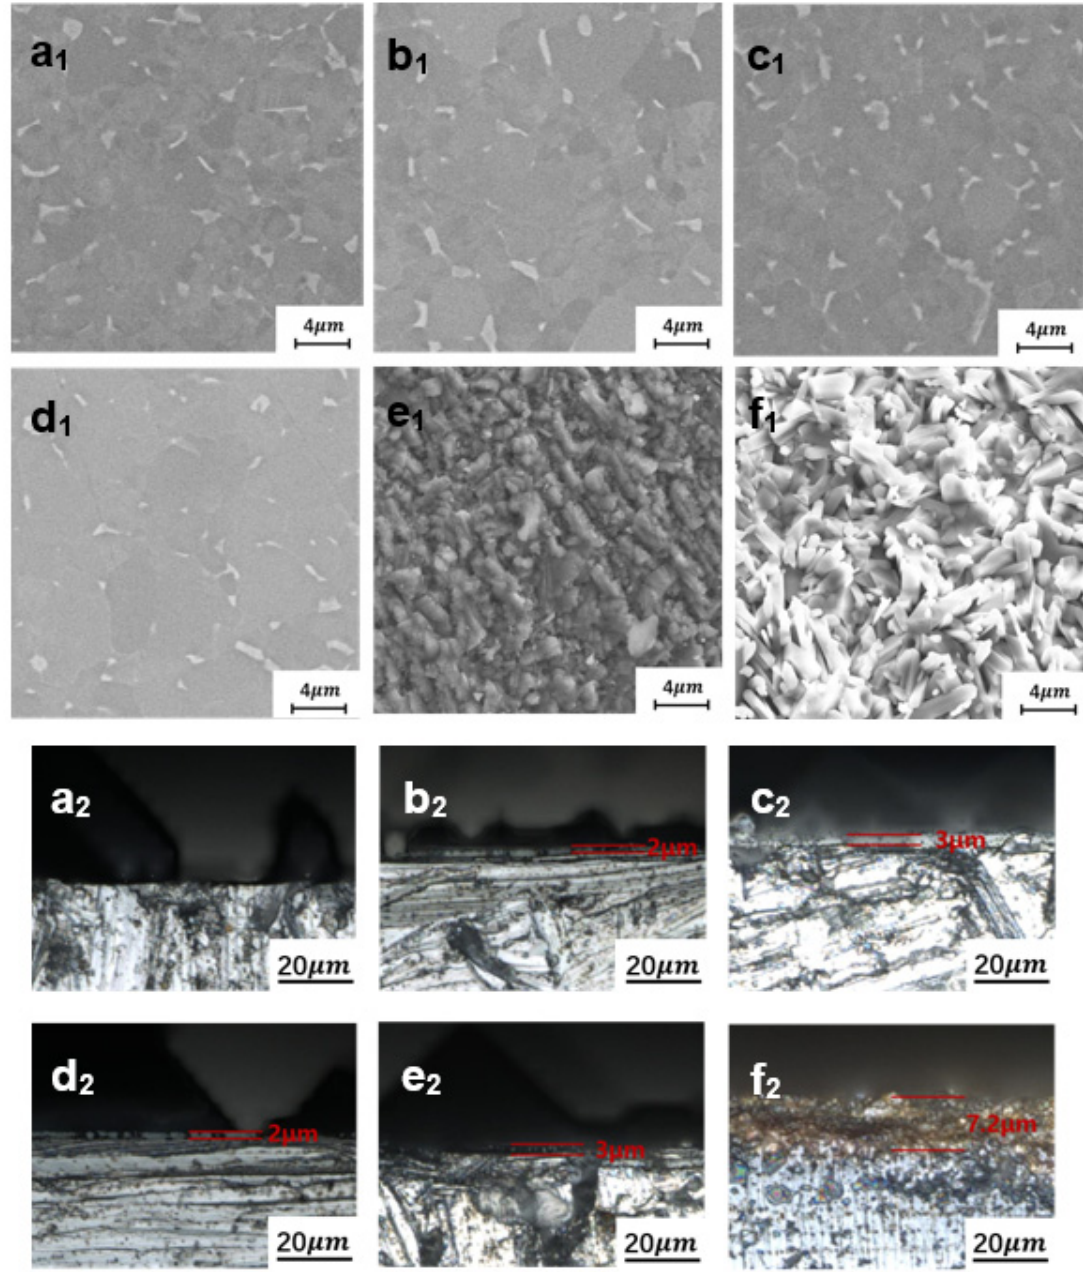
Figure 2. ( a 1 – f 1 ) SEM micrographs of ( a 1 ) bare Ti6Al4V, and inorganic thermal oxide coatings formed at ( b 1 ) 100 °C, ( c 1 ) 300 °C, ( d 1 ) 500 °C, ( e 1 ) 700 °C, and ( f 1 ) 900 °C; ( a 2 – f 2 ) thickness of ( a 2 ) bare Ti6Al4V, and inorganic thermal oxide coatings formed at ( b 2 ) 100 °C, ( c 2 ) 300 °C, ( d 2 ) 500 °C, ( e 2 ) 700 °C, and ( f 2 ) 900 °C measured by stereo light microscope.